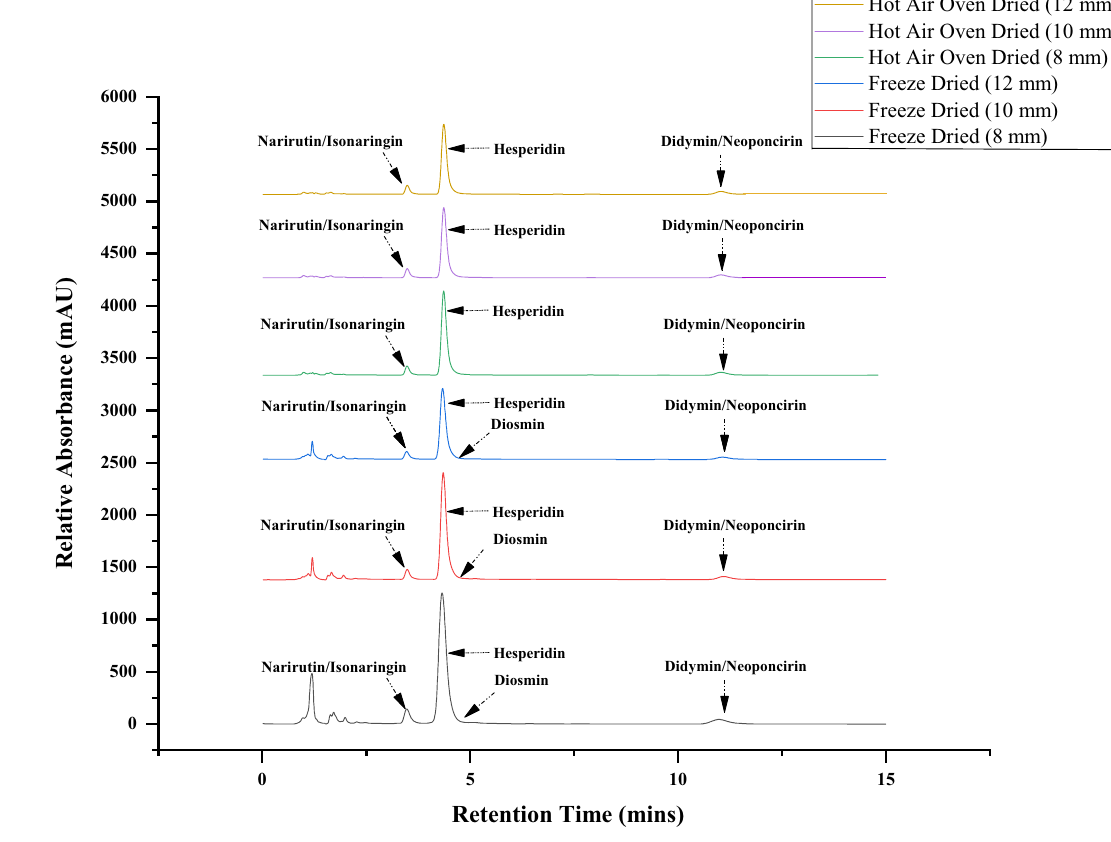
Figure 4. HPLC chromatogram of flavonoids content of dropped immature fruits C. sinensis L. Osbeck varies from size 8 mm, 10 mm and 12 mm after freeze drying and hot air oven drying recorded at wavelength 284